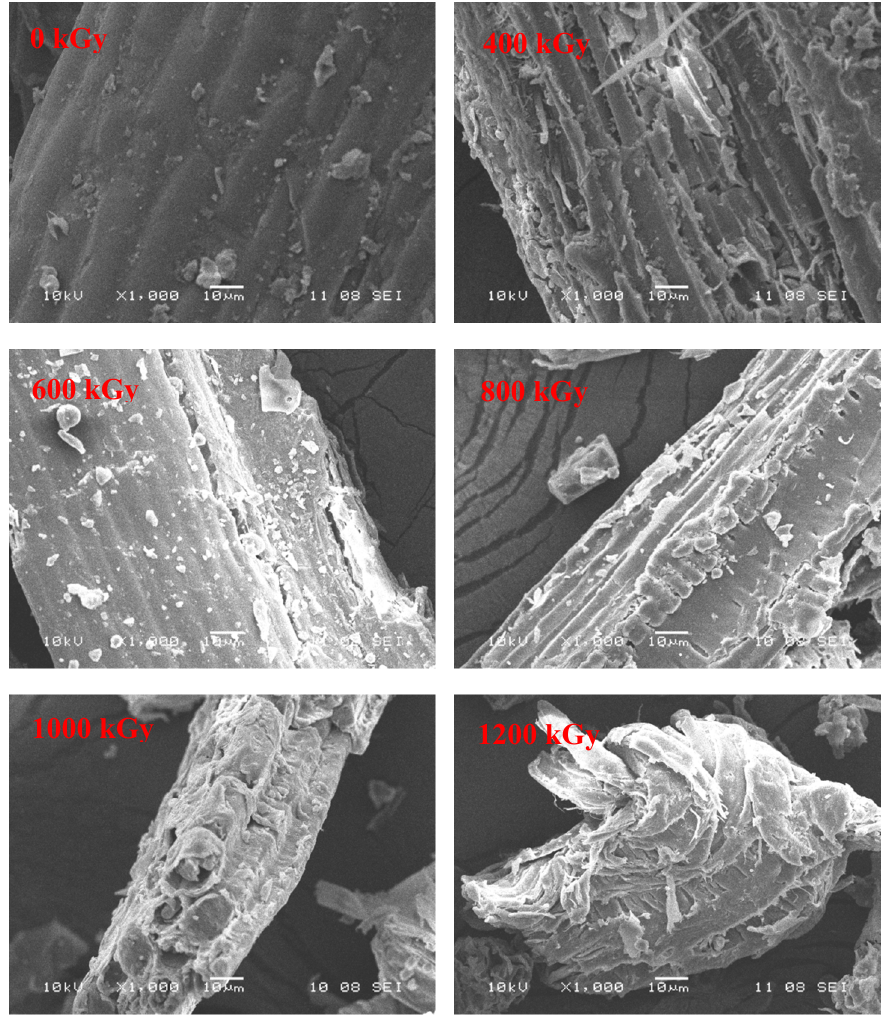
Figure 6. SEM photographs of untreated and irradiation-pretreated Miscanthus (1000×).